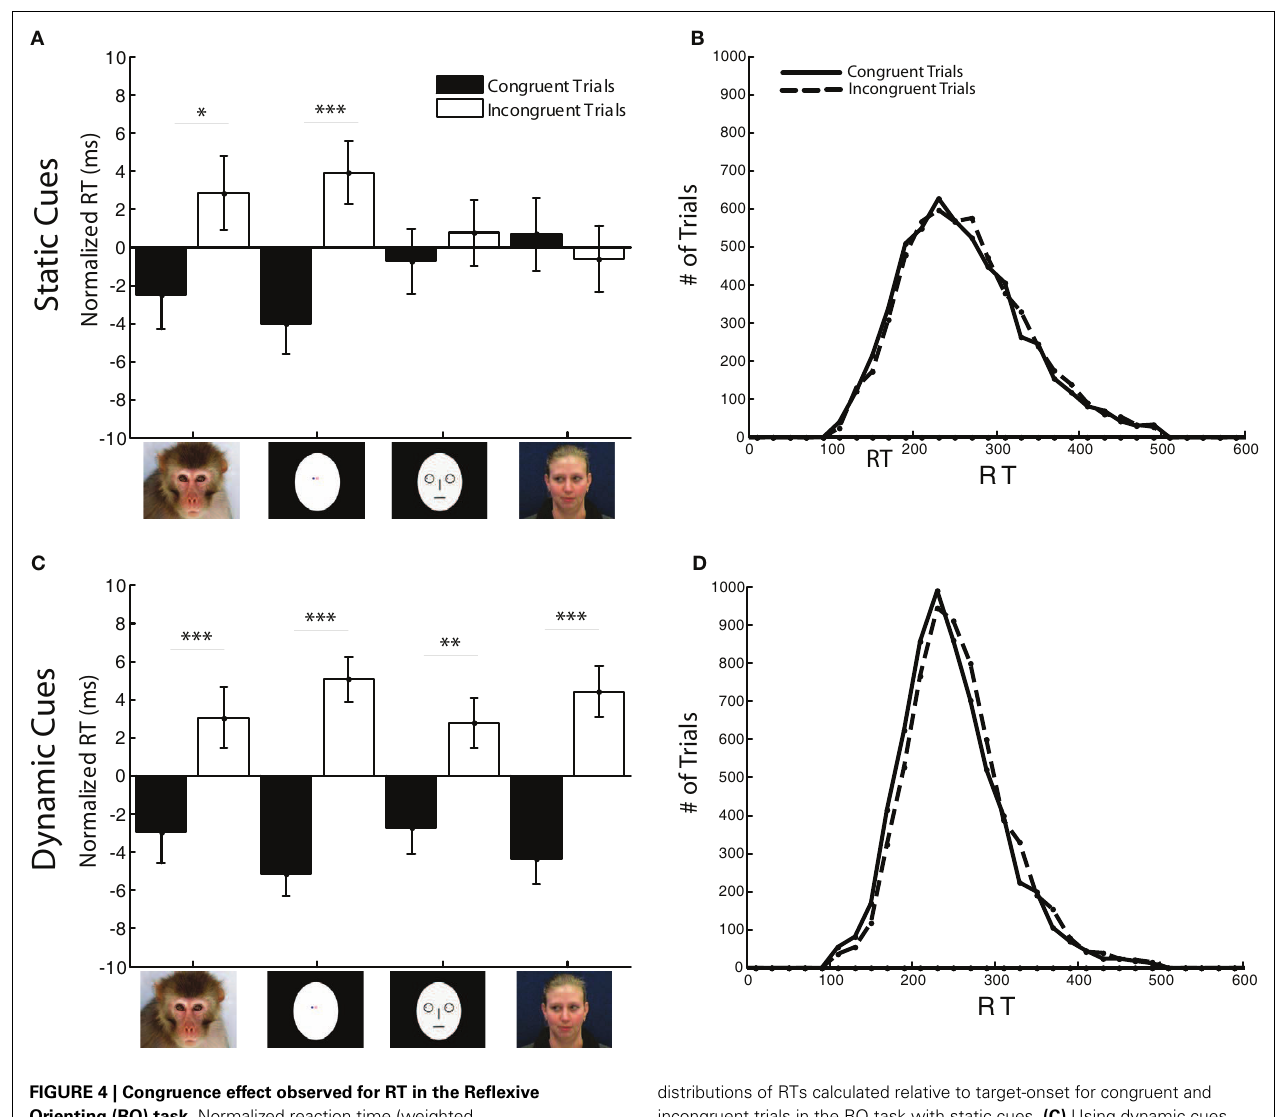
FIGURE 4 | Congruence effect observed for RT in the Reflexive Orienting (RO) task. Normalized reaction time (weighted mean ± weighted SEM in ms) for congruent and incongruent trials per stimulus category was calculated for both monkeys (F, C, and H). (A) Using static cues, congruency effects on RT were observed for monkey-face and spatial dot cues (* p < 0.05, ** p < 0.01, *** p < 0.001). (B) Density